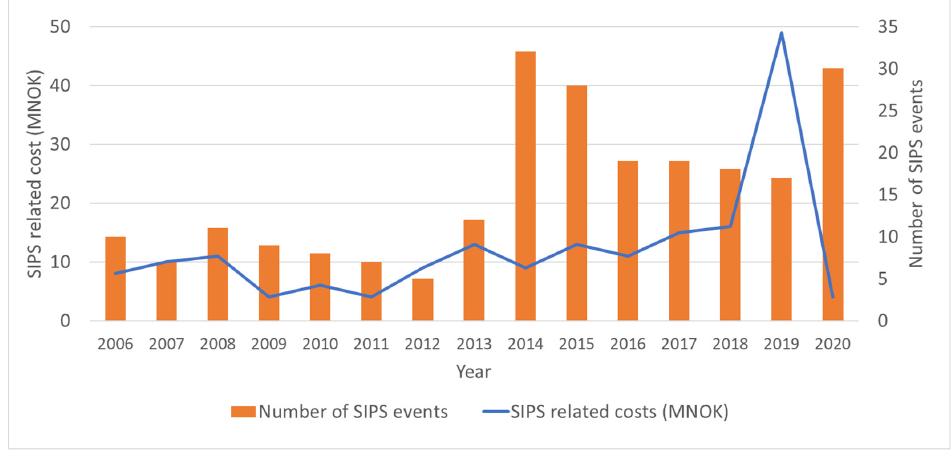
Figure 4. SIPS-related costs (based on information available in [58]) and total number of SIPS triggers (input provided by Statnett).